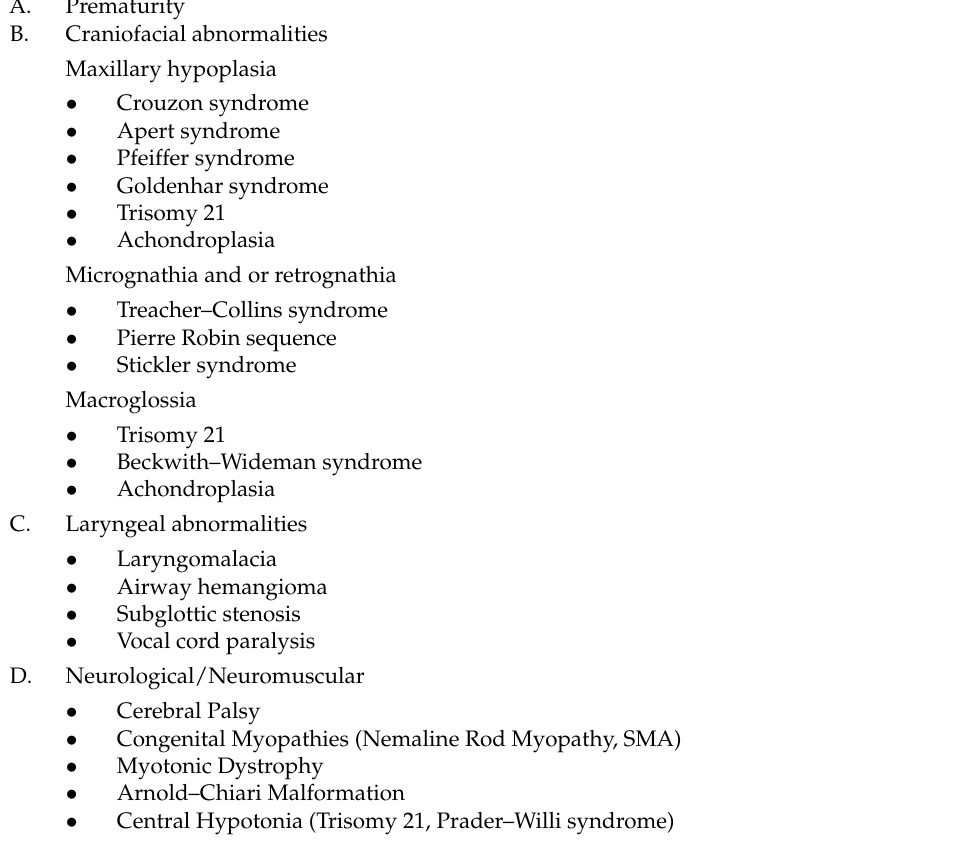
Table 2. Conditions in Neonates commonly associated with